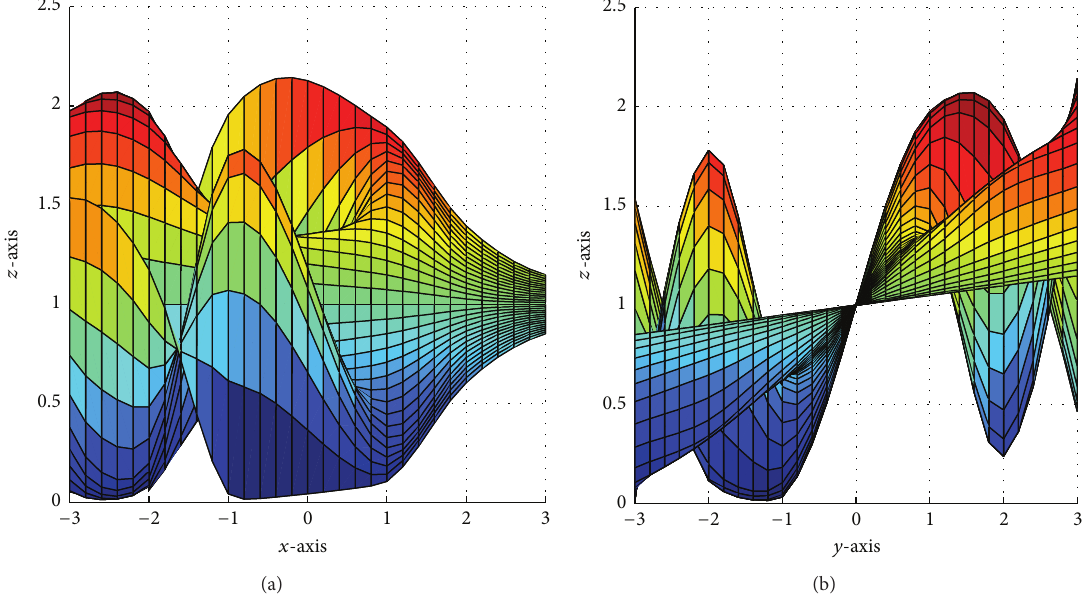
Figure 9: Positivity preserving surface: (a) 𝑥𝑧 -view and (b) 𝑦𝑧 -view for Figure 8, respectively.